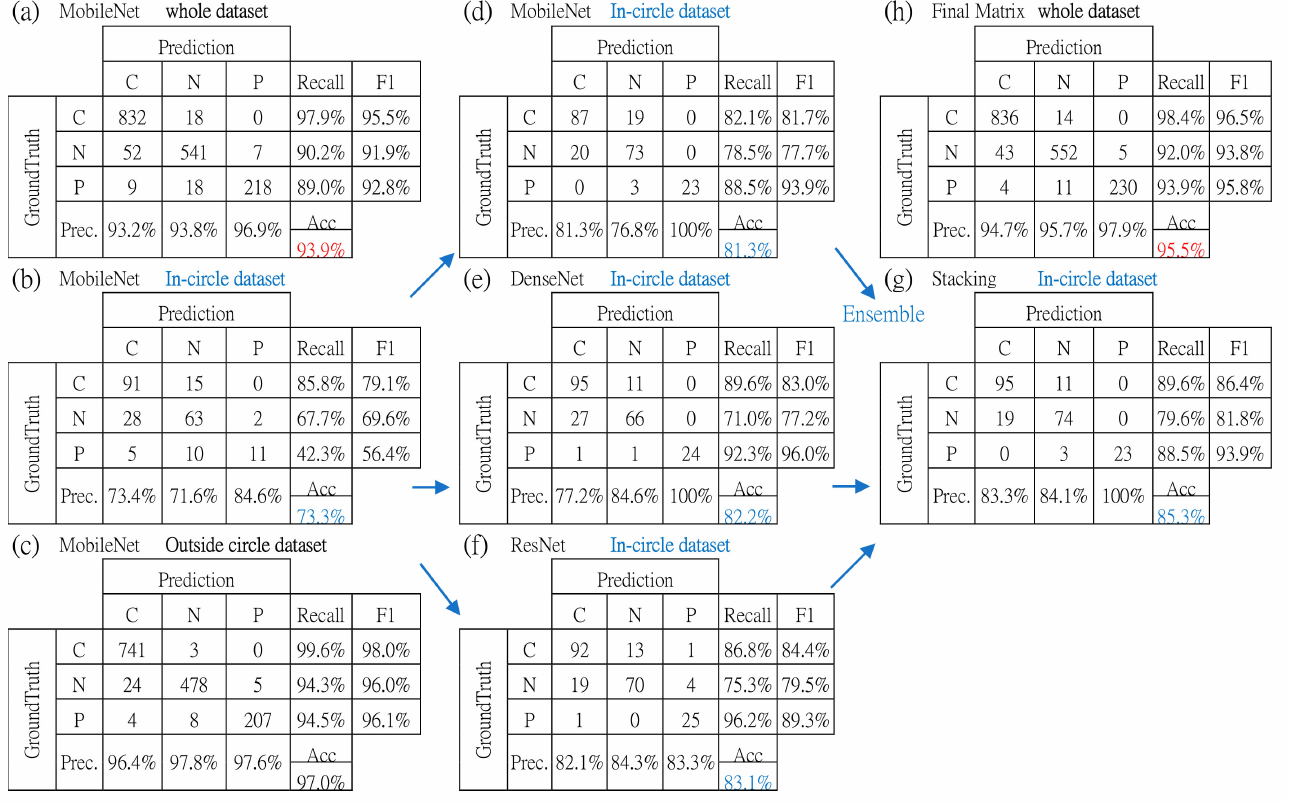
Figure 8. All relevant confusion matrices: ( a – c ) are for status before partition enhancement, ( d – f ) are the improvement of ( b ) with data augmentation on three models, ( g ) is the result of the ensemble, and ( h ) is the final result for all datasets. Dataset here means testing